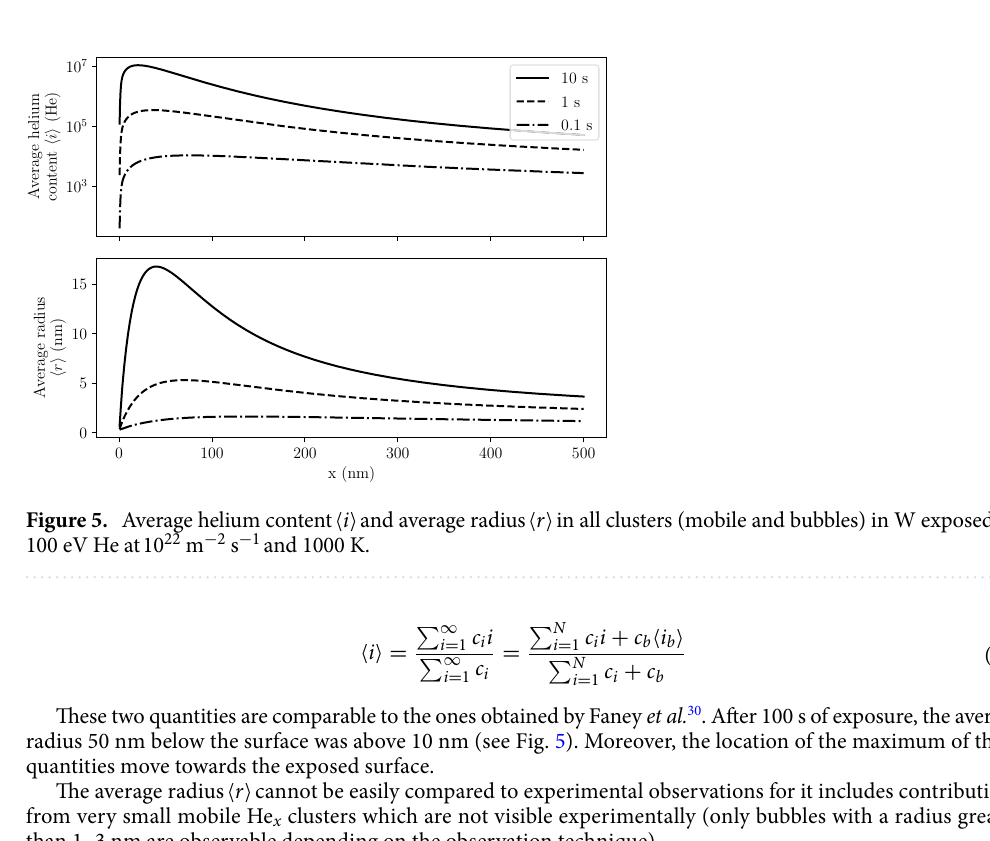
Figure 4. Profile of mean bubble radius and 1000 K.